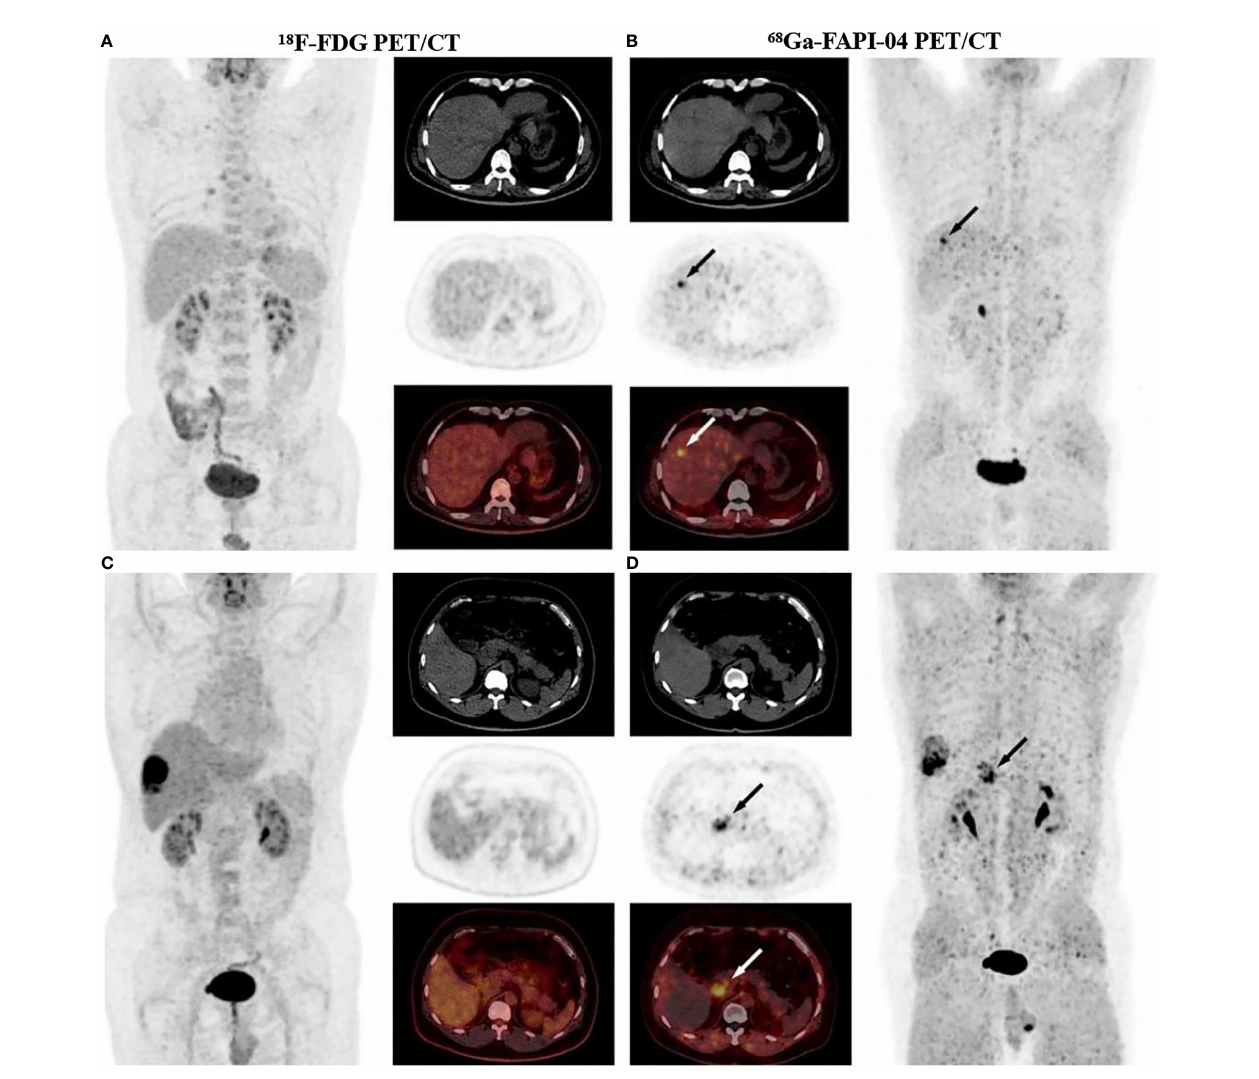
FIGURE 3 | A 53-year-old male diagnosed with moderately-differentiated HCC, 18 F-FDG PET/CT images did not detect intrahepatic positive fi ndings (A) , and 68 Ga- FAPI-04 PET/CT showed a strongly FAPI positive lesion in the right lobe of the liver (B) . In PET/CT images of another 53-year-old male diagnosed I with recurrent HCC and extensive peritoneal diffusion, a small metastatic lesion was not detected in 18 F-FDG PET/CT (C) , which was found with increased uptake in 68 Ga-FAPI-04 PET/CT (D) . Therefore, 68 Ga-FAPI-04 PET/CT was more sensitive than 18 F-FDG PET/CT in the detection of HCC and peritoneal metastatic carcinoma. With permission from Wang et al.